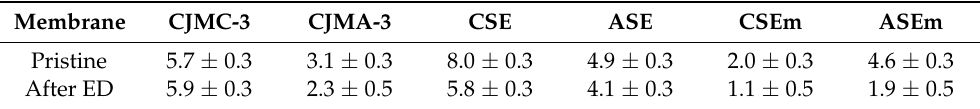
Table 6. Conductivity (mS/cm) of the studied membranes before and after electrodialysis processing of the model solution. Data obtained in 0.1 M NaCl solution. Membrane CJMC-3 CJMA-3 CSE ASE CSEm ASEm Pristine 5.7 ± 0.3 3.1 ± 0.3 8.0 ± 0.3 4.9 ± 0.3 2.0 ± 0.3 4.6 ± 0.3 After ED 5.9 ± 0.3 2.3 ± 0.5 5.8 ± 0.3 4.1 ± 0.3 1.1 ± 0.5 1.9 ±